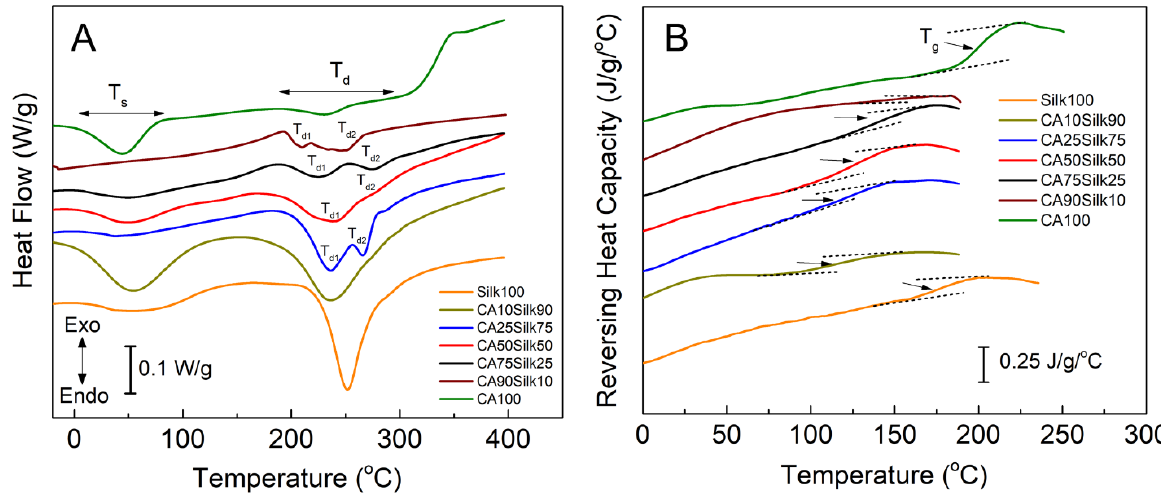
Figure 4. DSC scans of ( A ) heat flow and ( B ) reversing heat capacity for methanol washed silk-cellulose acetate composite films. Table 1. Thermal analysis data of different silk-cellulose acetate films produced from EMMIAc *.